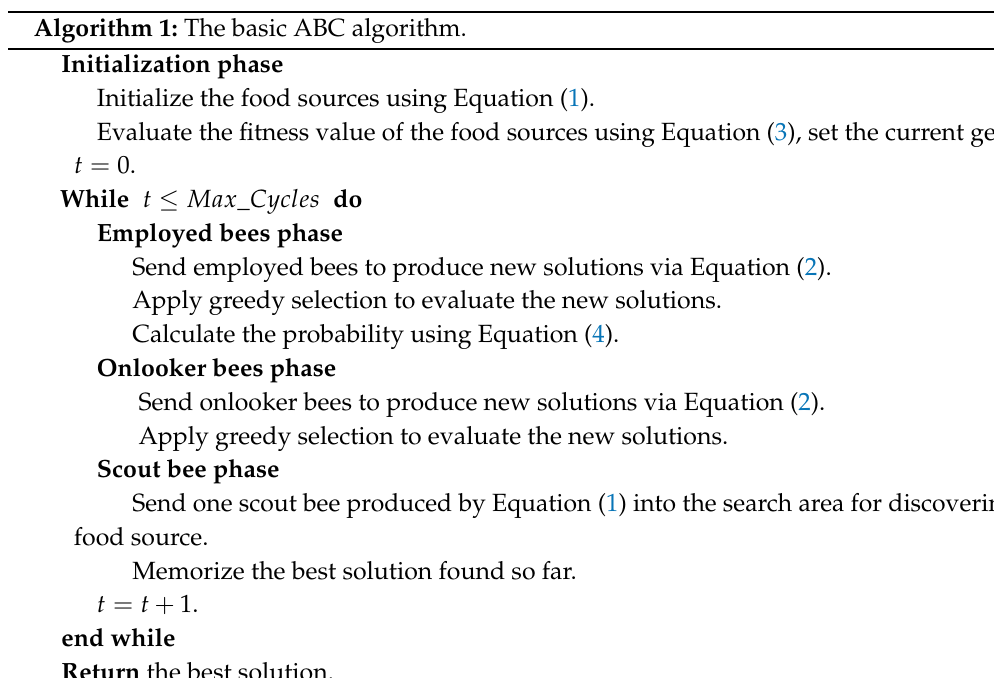
Algorithm 1: The basic ABC